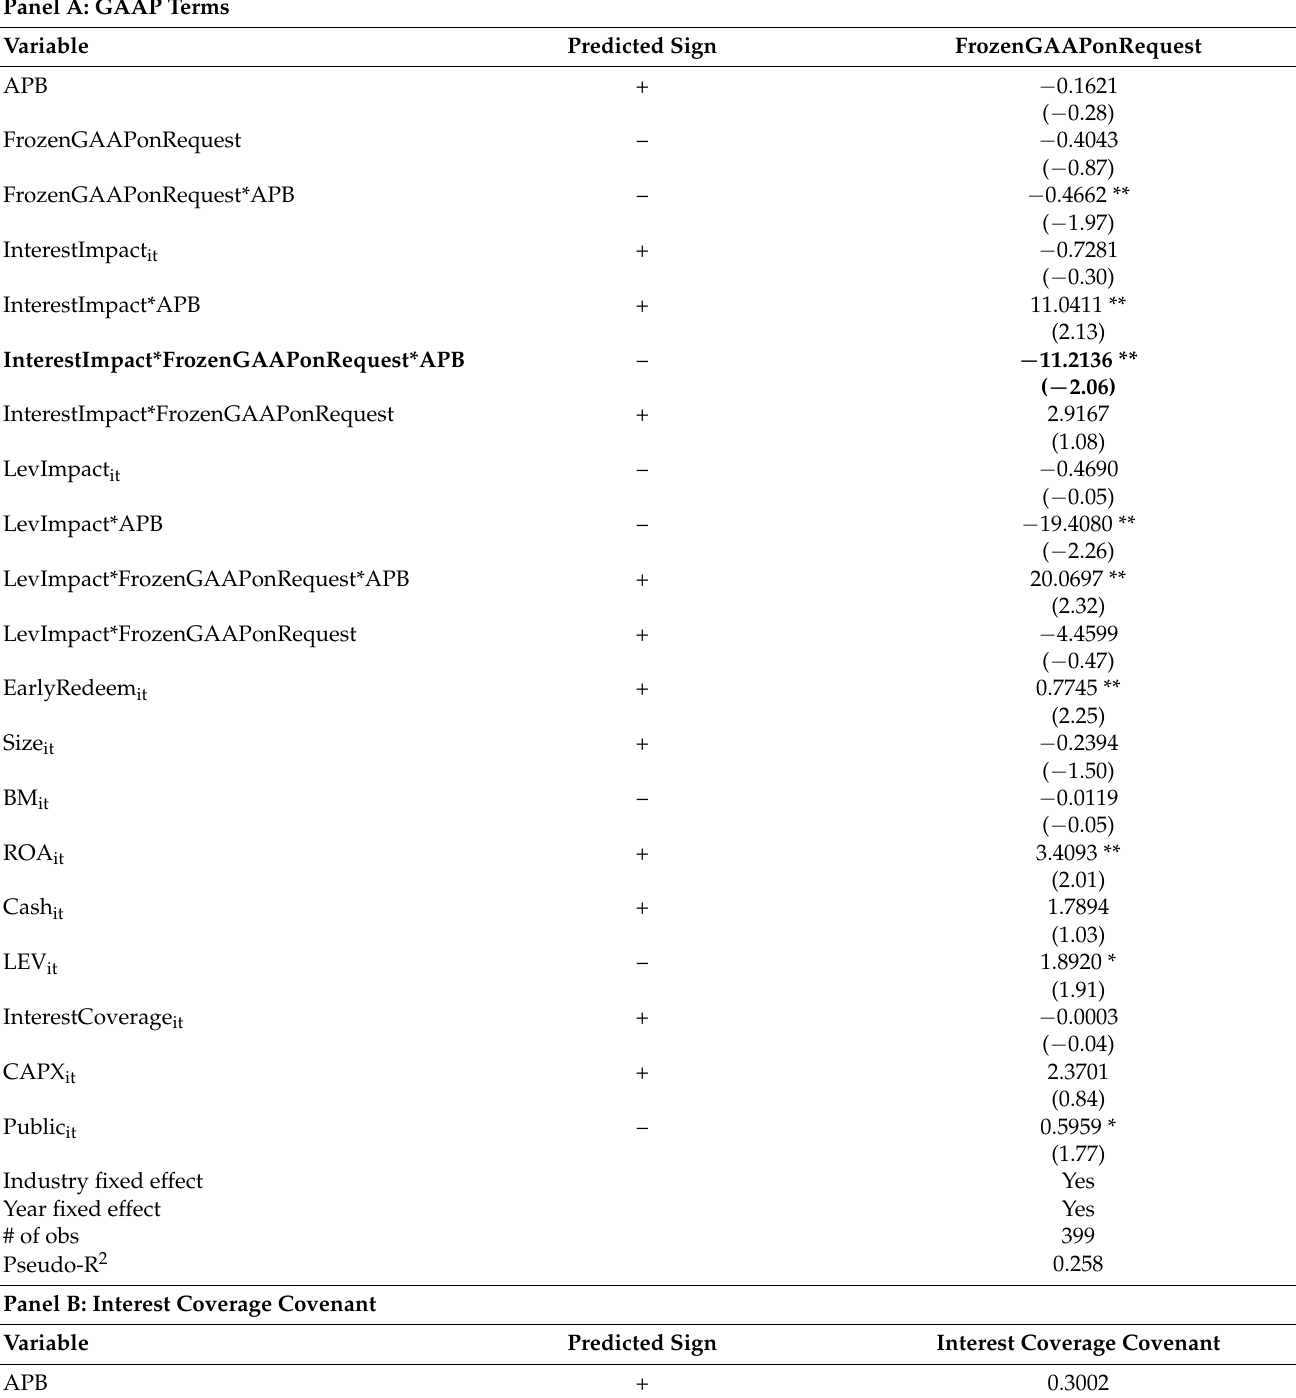
Table 6. Debt contracting practices and repurchase